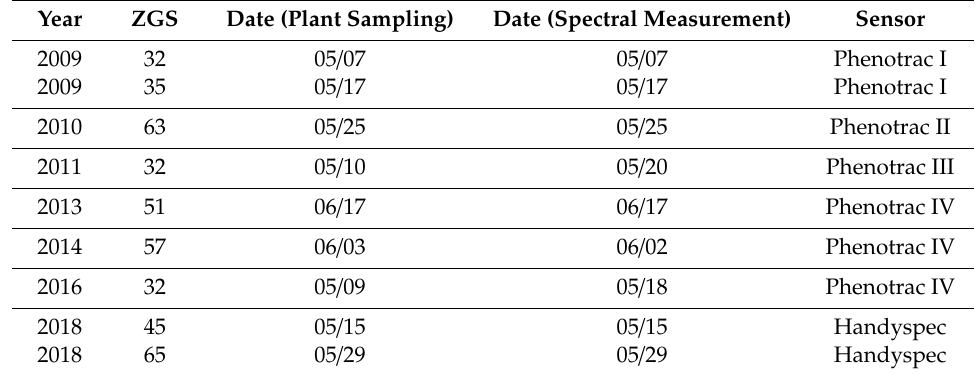
Table 2. Dates (month / day) and growth stages (Zadok’s growth stage ZGS) for reference plant sampling and spectral measurements.